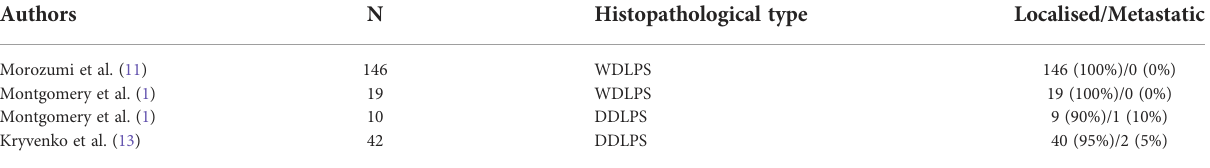
TABLE 1 Proportion of distant metastases according to tissue in paratesticular liposarcomas. Authors